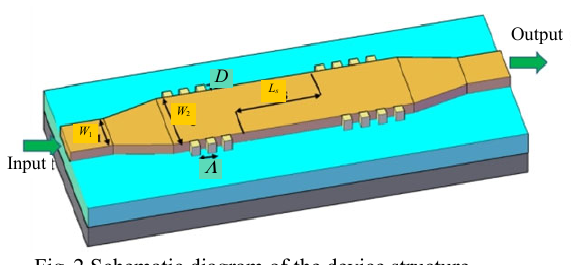
Fig. 2 Schematic diagram of the device structure. The sidewall gratings supported the coupling between the E and E modes [14], which could 11 21 increase the overlap between the two coupled modes and reduced the coupling length. Since the E mode 21 is anti-symmetric, we designed an offset of / 2 Λ for the grating on the left and right